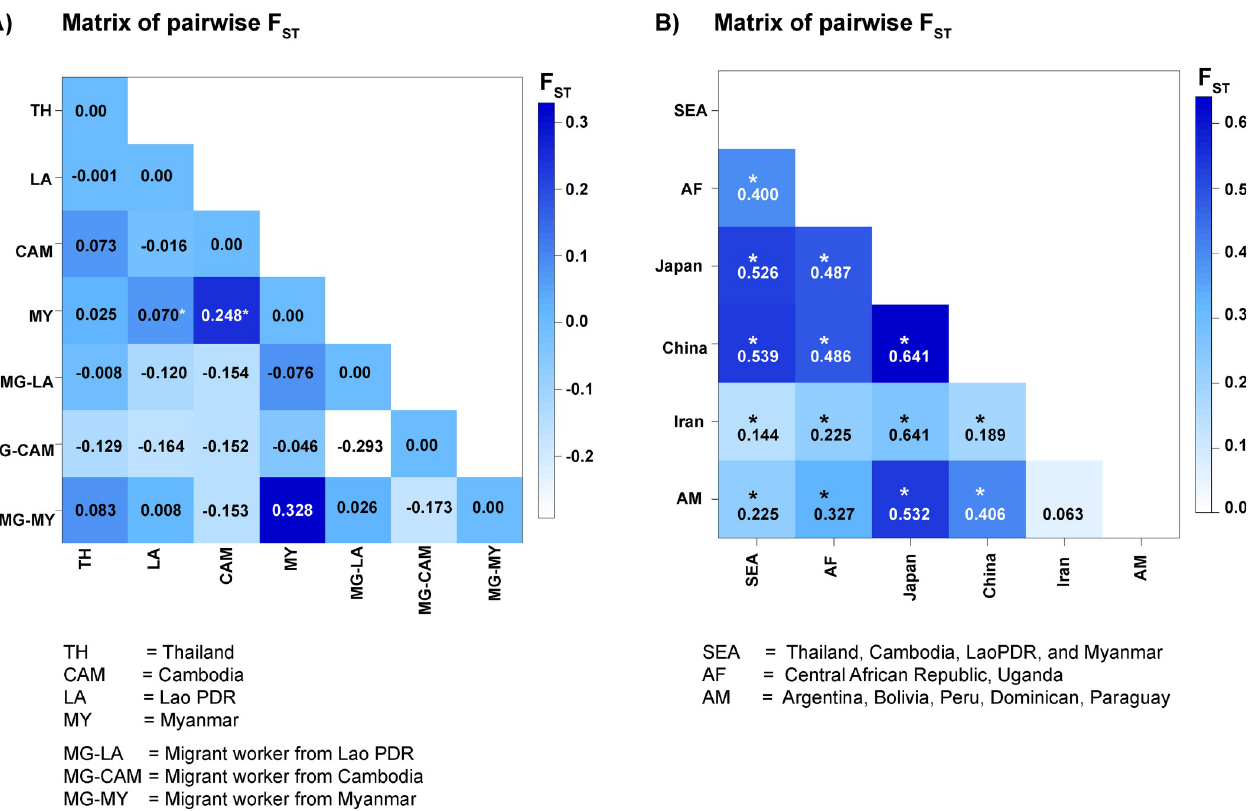
Fig 2. Population-genetic differentiation between populations (partial cox 1 gene sequences) of S . stercoralis from migrant workers (from Myanmar, Lao PDR and Cambodia) living in Thailand and other parts of the world (China, Japan, Iran, and African and South American continents). A) Population relatedness represented by pairwise F ST values between worms from each country. B) Population relatedness represented by pairwise F ST values between worms from combined population from Thailand, Myanmar, Lao PDR and Cambodia (Southeast Asia: SEA) and different regions (China, Japan, Iran, African and South American continents). � represents significant difference ( P <